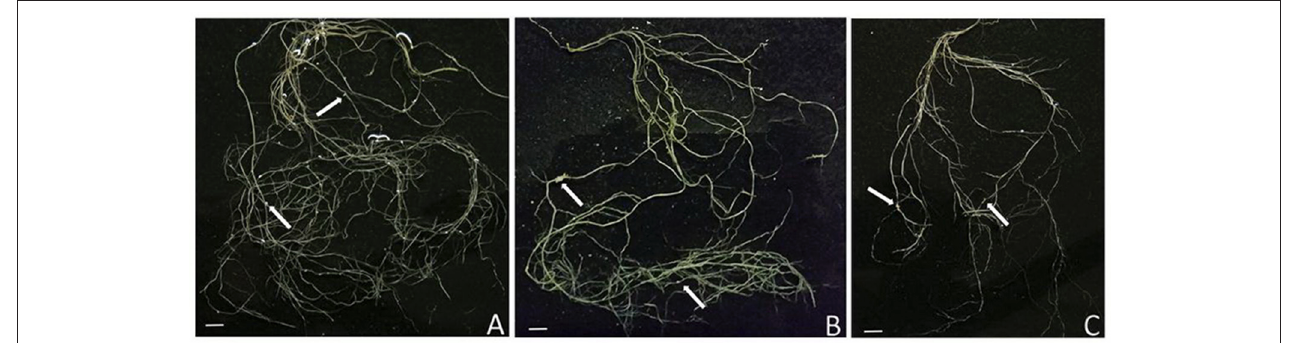
FIGURE 5 | Images are of the root system of 42-days-old M. truncatula plants inoculated with S. meliloti then grown for 28 dpi. The arrows indicate the position of a nodule. Note the differences in the total root length and size of nodules in each treatment. (A) Roots of vertical gravitational control seedlings. (B) Roots of horizontal control seedlings. (C) Roots from clinorotated seedlings. Scale bars = 1cm.